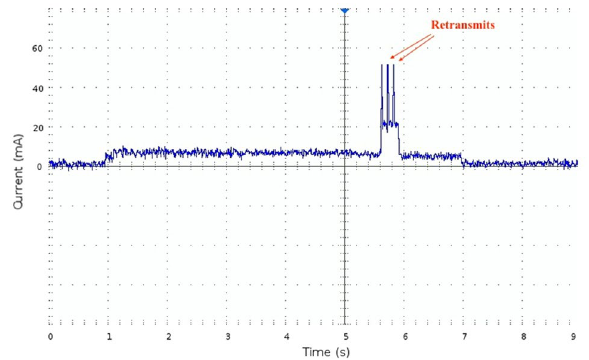
Fig. 7 Sensor mote RSSI values in the mariculture laboratory located in the University of Namibia Sam Nujoma campus